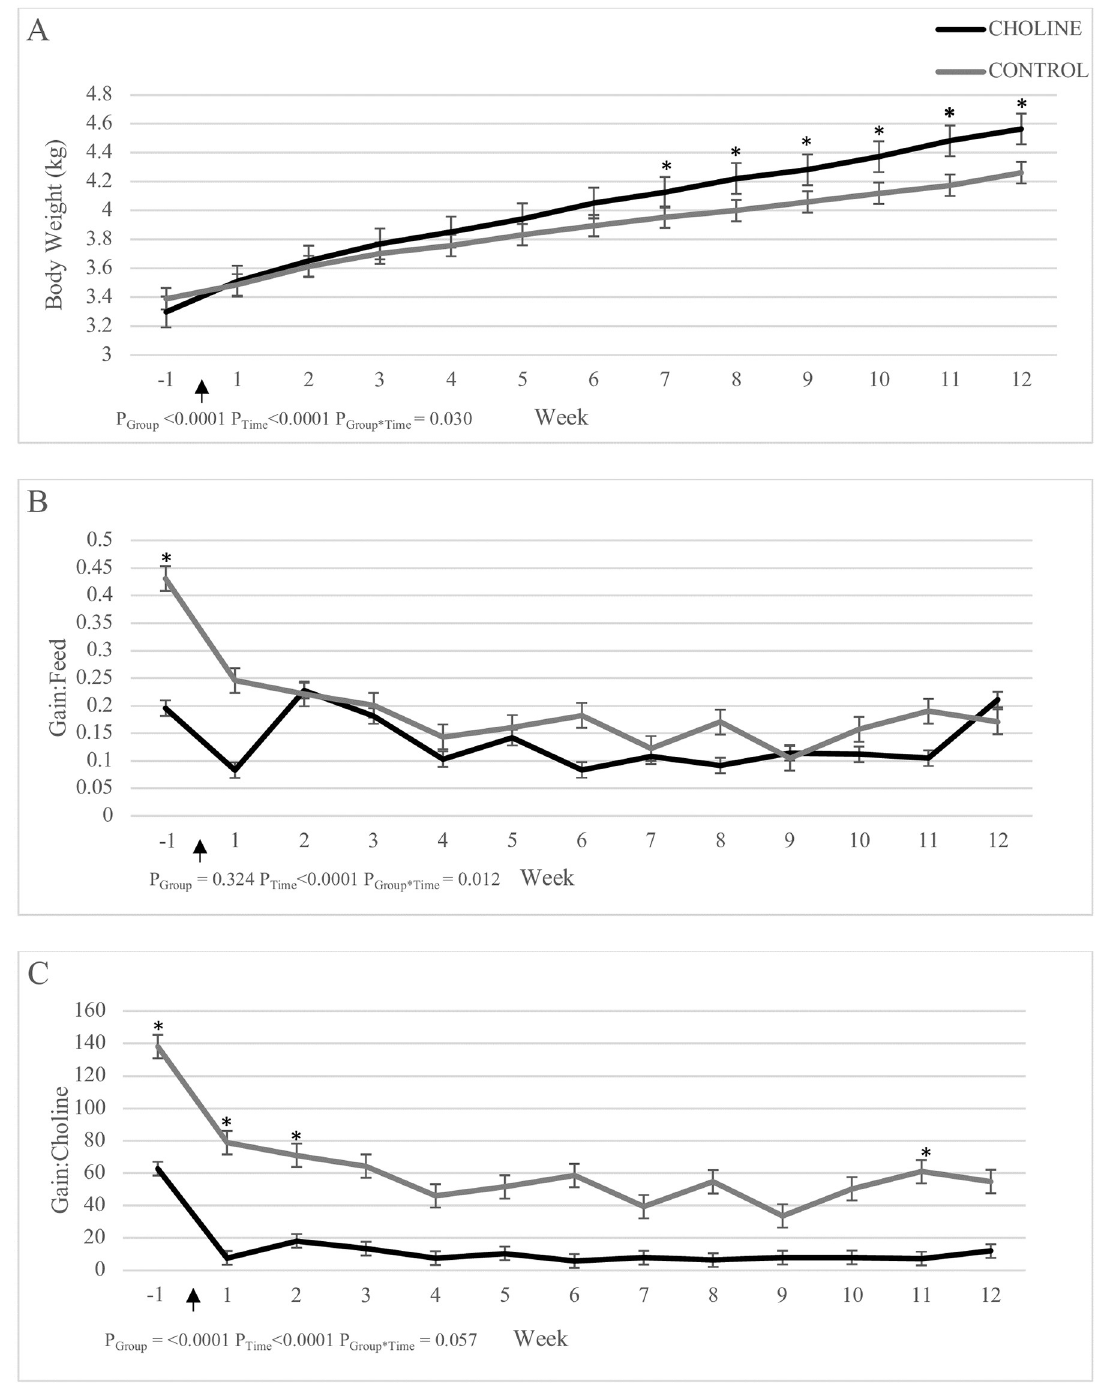
Fig 2. Weekly body weight (A), weekly Gain:Feed ratio (B) and weekly Gain:Choline ratio (C) of post-gonadectomy kittens supplemented with additional choline (CHOLINE, n = 8) for 12 weeks compared to a group fed only the base diet (CONTROL, n = 7). Gonadectomy occurred at week 1